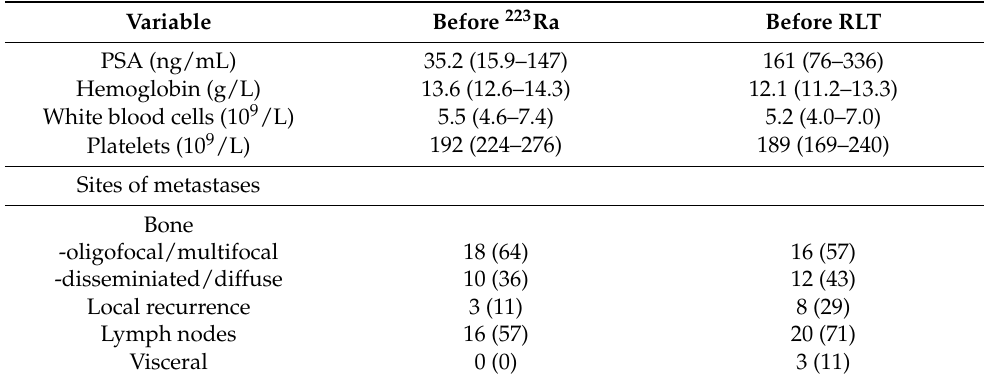
Table 2. Patient